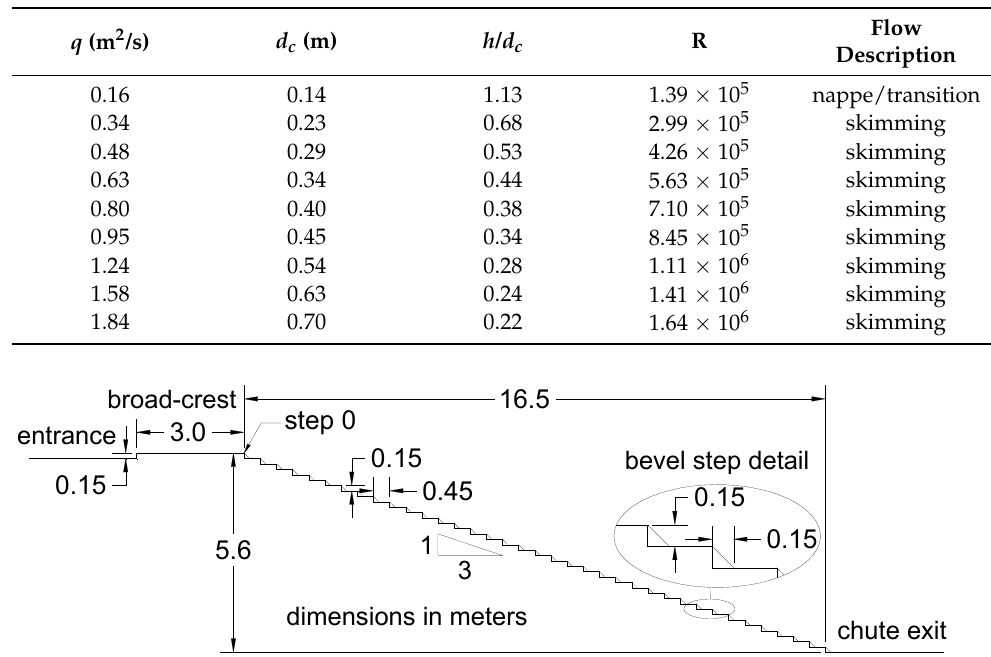
Table 1. Test parameters.